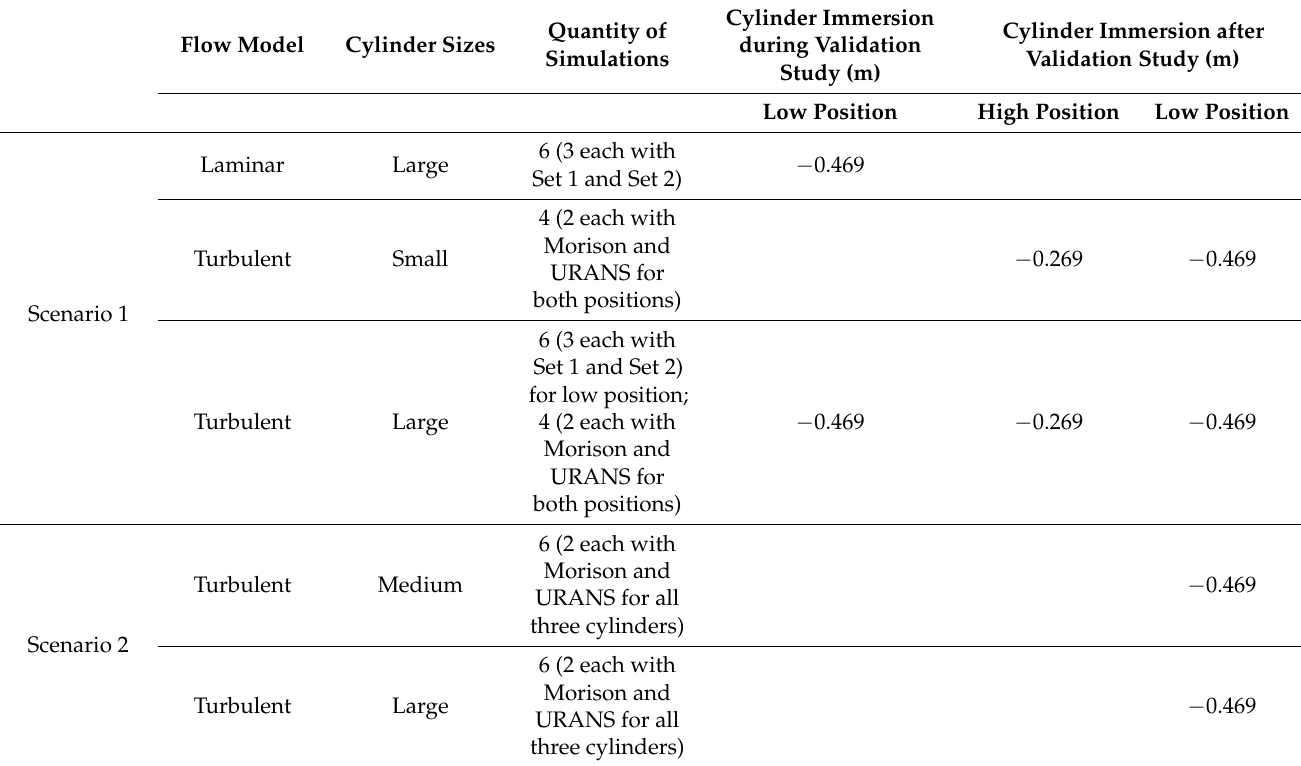
Table 4. Overview of the numerical